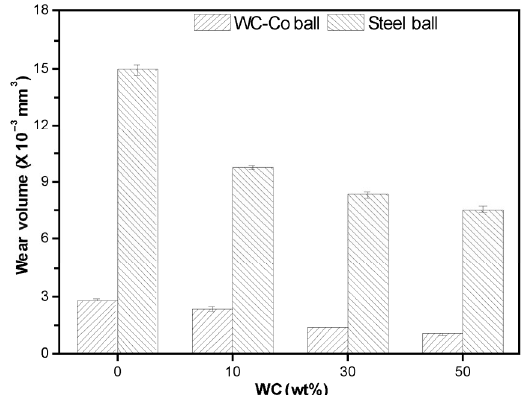
Fig. 8 Wear volumes of WC-Co and steel balls as a function of WC content at 20 N